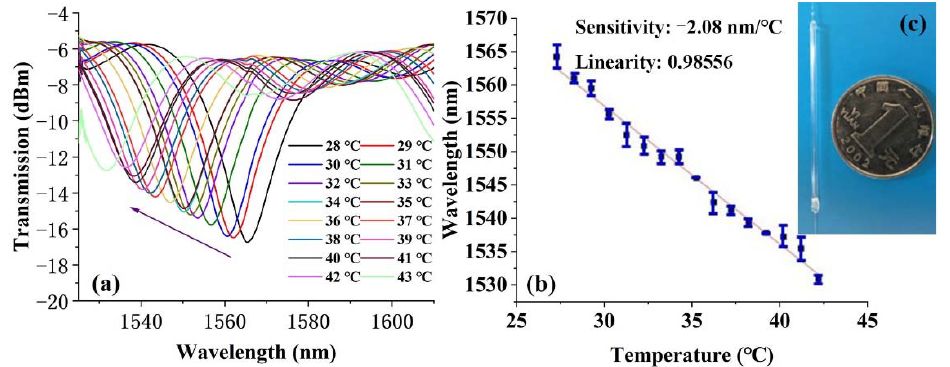
Figure 7. ( a ) Interference spectra as a function of environment temperature and ( b ) temperature sensing characteristic curve for microfiber taper elaborated by silicon NPs during 28 °C–43 °C. ( c ) Picture of microfiber packaged in glycerin by a capillary.